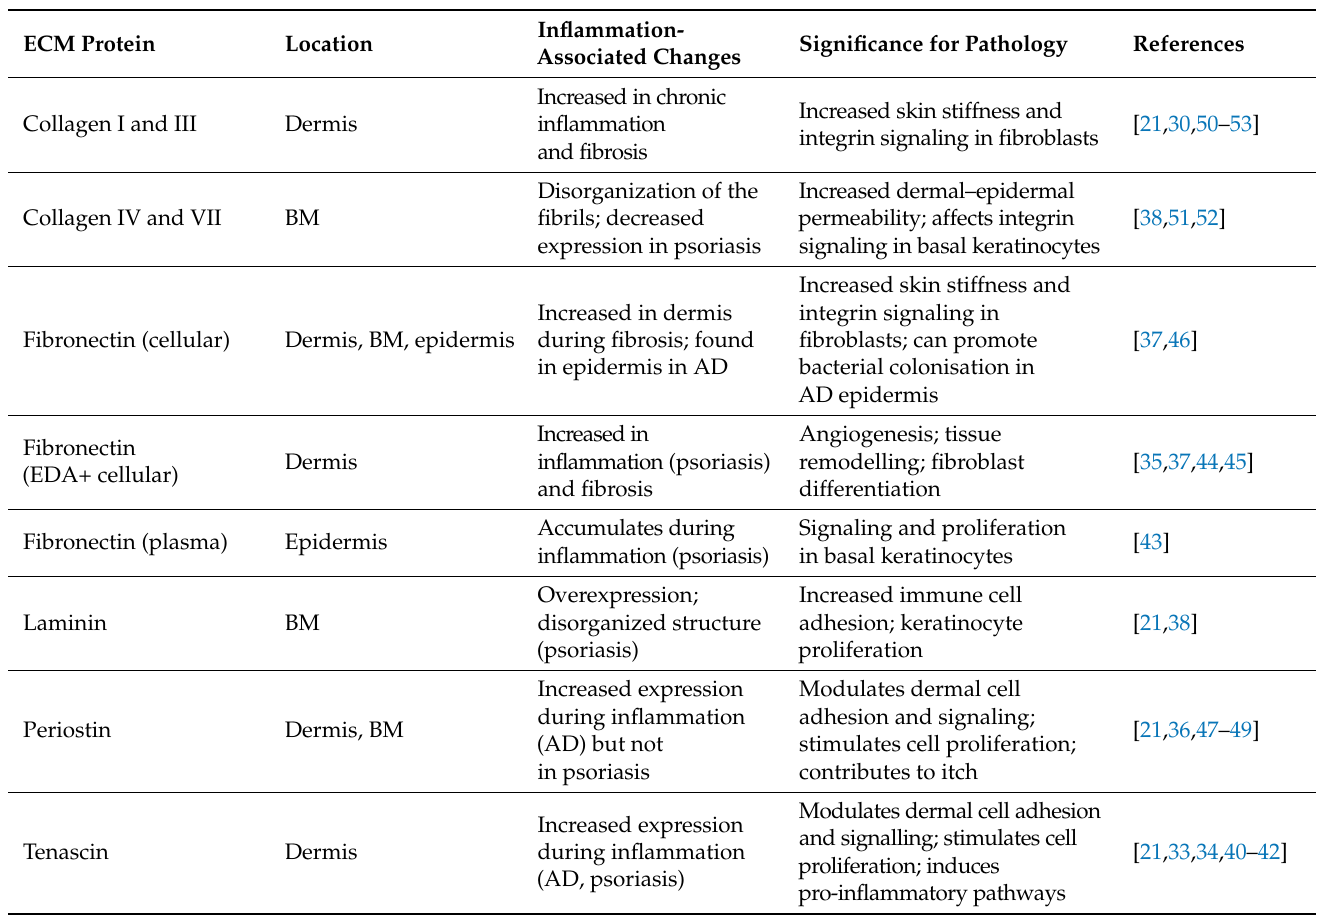
Table 1. Skin ECM protein alterations during inflammation. For additional information on the immunomodulatory functions of the ECM, see ref.